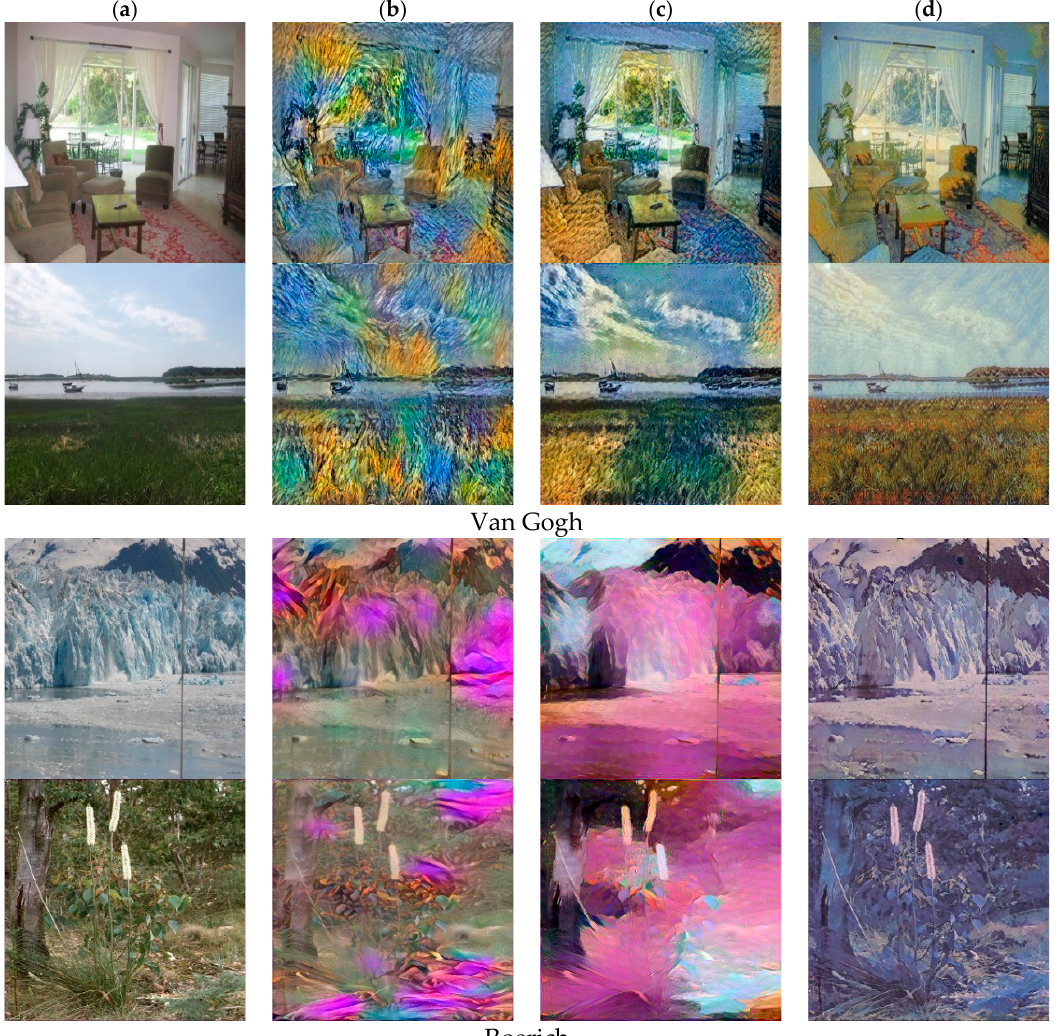
Figure 9. Contrast with slow style transfer methods. ( a ) Inputs. ( b ) Gatyes et al. [1]. ( c ) MMD [17]. ( d ) Ours.